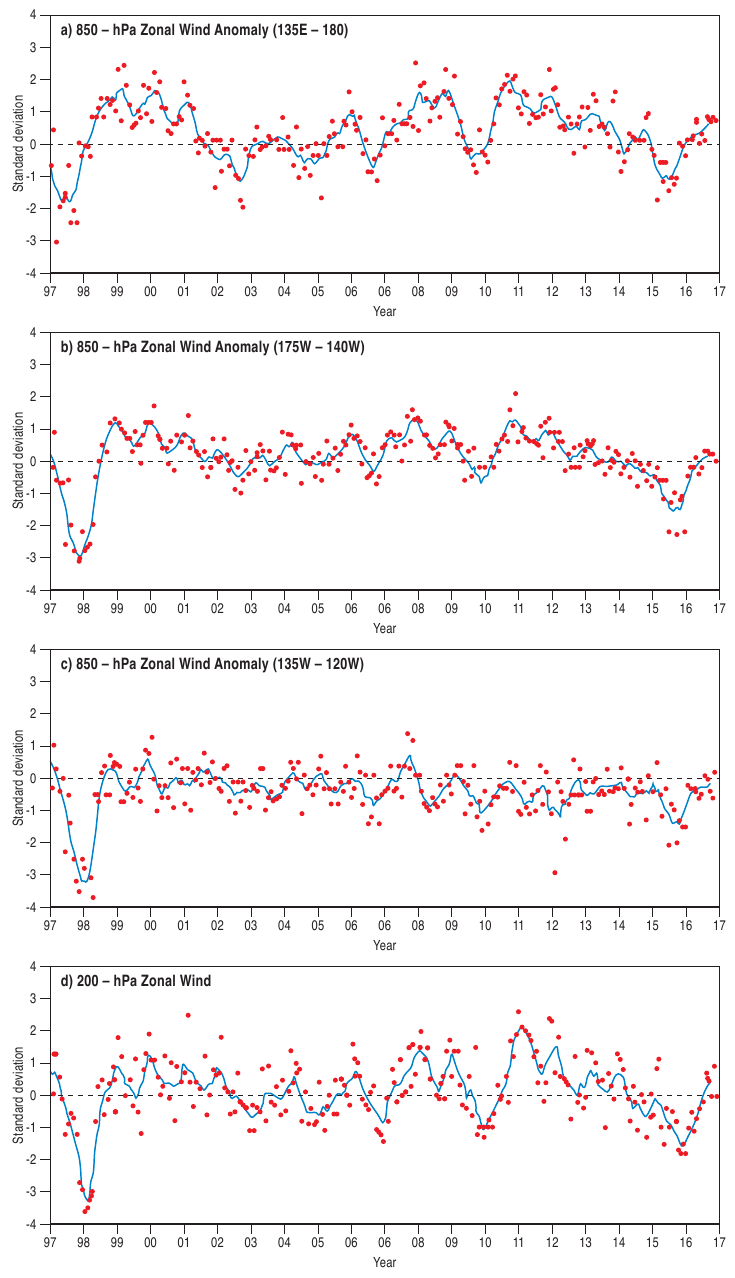
Figure 4. Time series of ENSO wind indices for various regions (see Table 2) 1997–2016. The weakening of the zonal winds is especially apparent for the 1997–1998 El Niño event. Sourced and redrawn from the Climate Diagnostics Bulletin